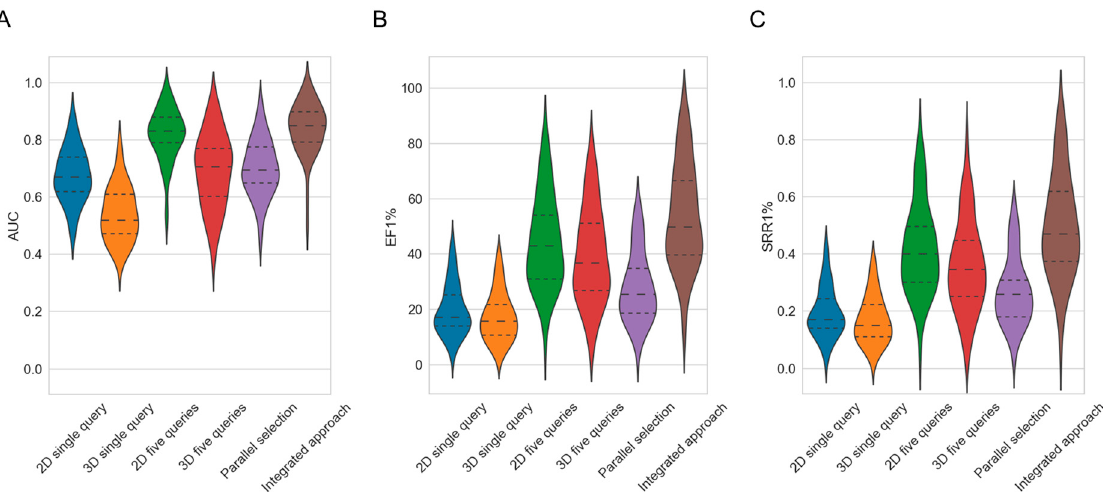
Figure 2. Violin plots showing the distributions of ( A ) AUC, ( B ) EF1% and ( C ) SRR1% values obtained by the different approaches across the 50 investigated targets, with “2D single query” representing the baseline performance of the 2D fingerprint-based screening method, “3D single query” representing the baseline performance of the 3D shape-based method, “2D five queries” representing the performance of the 2D method using five query molecules (Strategy 1), “3D five queries” representing the performance of the 3D method using five query molecules (Strategy 1), “parallel selection” representing the performance of the 2D and 3D approach when combined using the balanced, parallel selection method (Strategy 2), and “integrated approach” representing the combination of Strategy 1 and Strategy 2 (a combined hit list was generated by selecting an equal number of hits from the 2D and 3D methods which were each run with sets of five query molecules). The dashed lines mark the quartiles of the distributions.